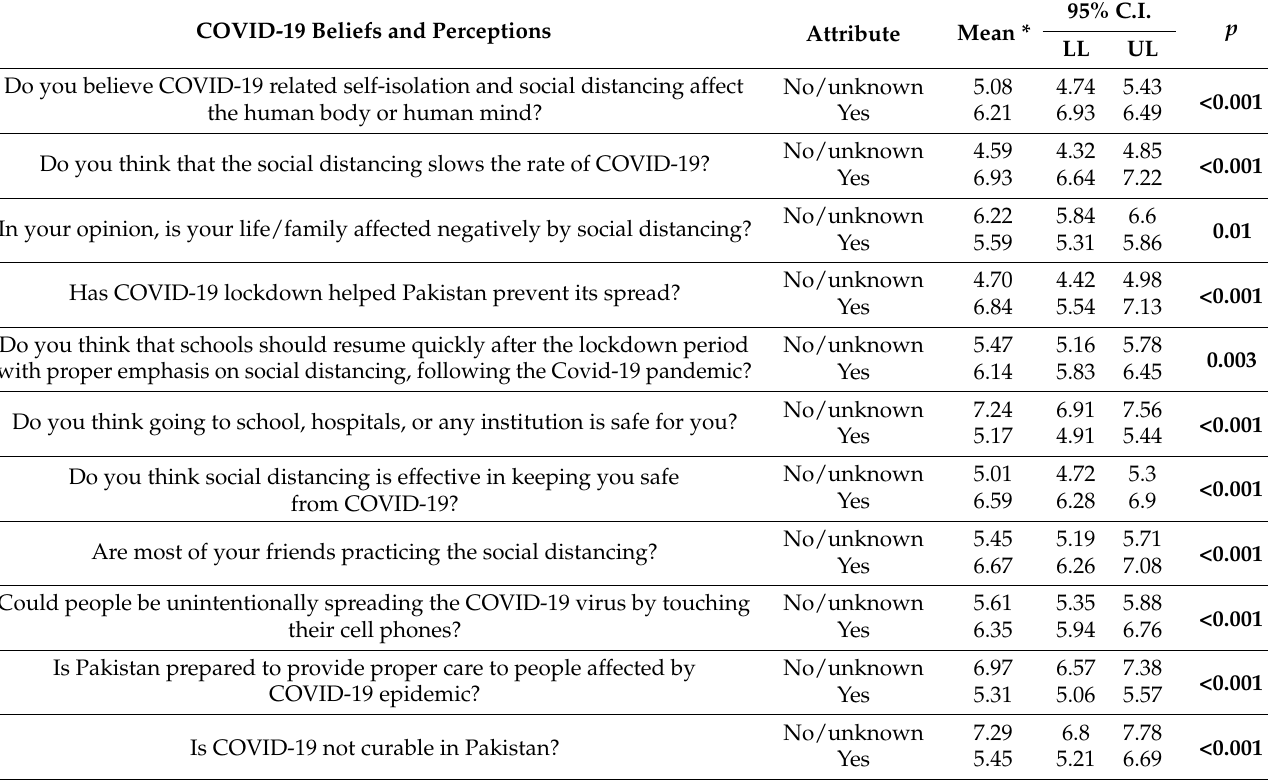
Table 3. Analysis of variance for comparison of mean number of COVID-19 prevention behavior * by participants’ beliefs and perceptions about COVID-19, Depalpur City, Pakistan,